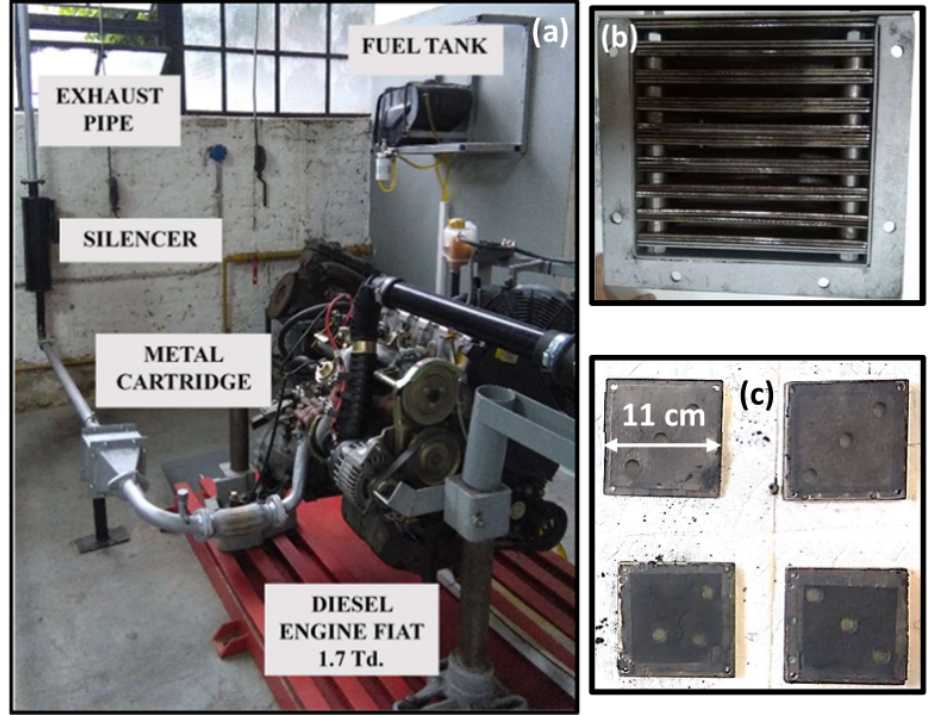
Figure 12. ( a ) Bench engine with metallic cartridge coupled; ( b ) front view of eight ceramic papers between meshes stacked inside the metal cartridge; ( c ) catalytic ceramic papers after test bench assay from which samples of 16 mm were extracted for catalytic laboratory TPO tests.